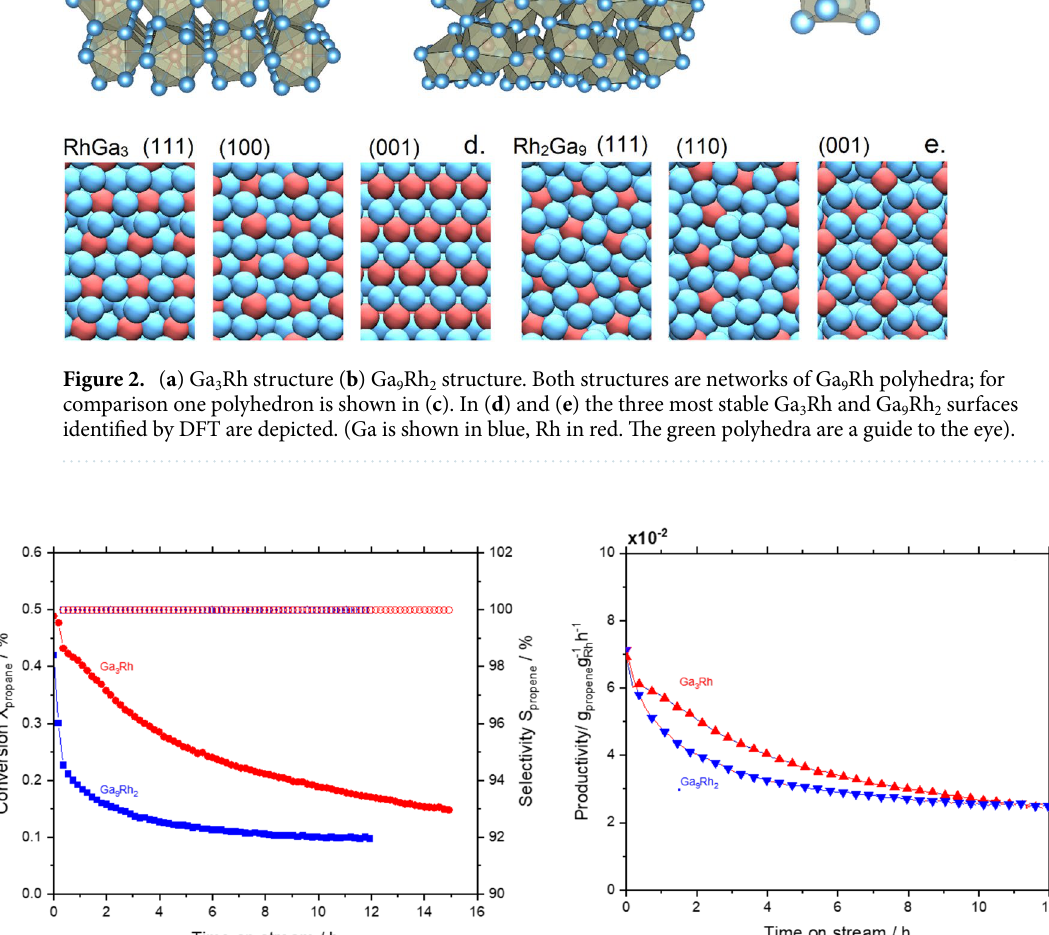
(Table S5, SI) relative to pure Rh (Ga 3 Rh: − 0.2 eV (exp.) and -0.12 eV (DFT); Ga 9 Rh 2 : + 0.2 eV (exp.) and + 0.22 eV (DFT) relative to pure Rh). A more detailed discussion of the core level shifts is given in the SI.